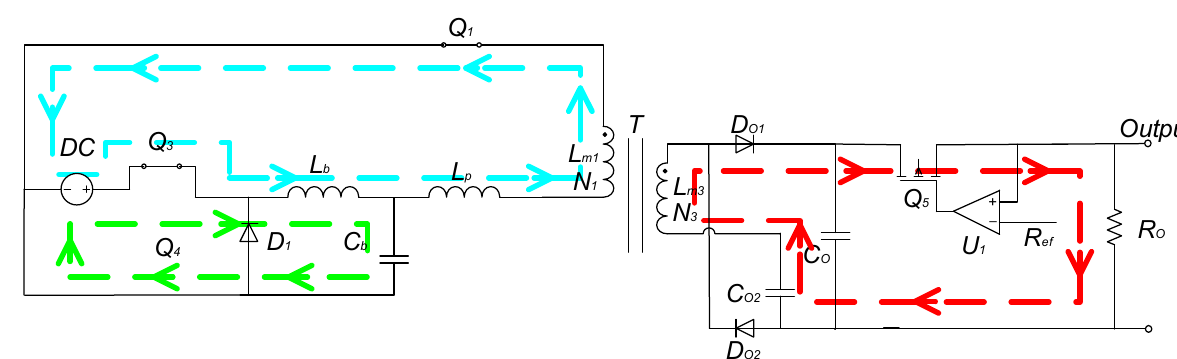
Figure 6. The equivalent circuit diagram when Q 1 is turned on. According to KCL, Hence,